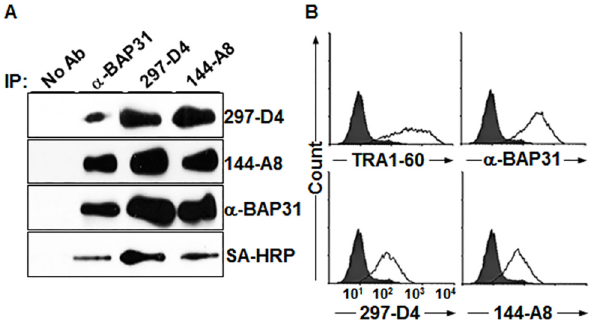
Fig 1. MAb 297-D4 and MAb 144-A8 recognize BAP31 on the cell surface of hESCs. (A) Immunoprecipitation of biotinylated hESCs with α -BAP31, 297-D4, and 144-A8 antibodies. Immunoprecipitates were detected by western blots with the indicated antibodies or SA-HRP. (B) Flow cytometric analysis of hESCs with anti-TRA-1-60, α -BAP31, 297-D4, or 144-A8